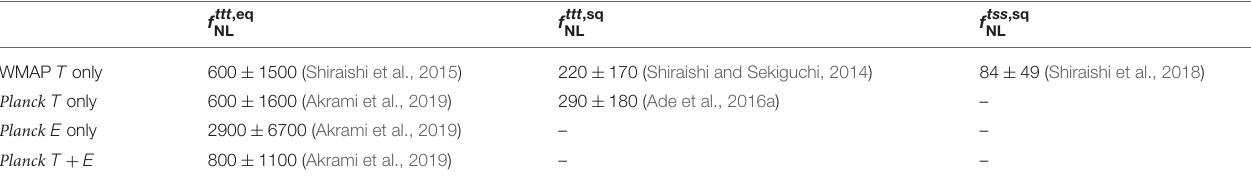
TABLE 1 | CMB constraints on three tensor non-linearity parameters: f ttt ,eq NL (6), f ttt ,sq NL (10), and f tss ,sq NL